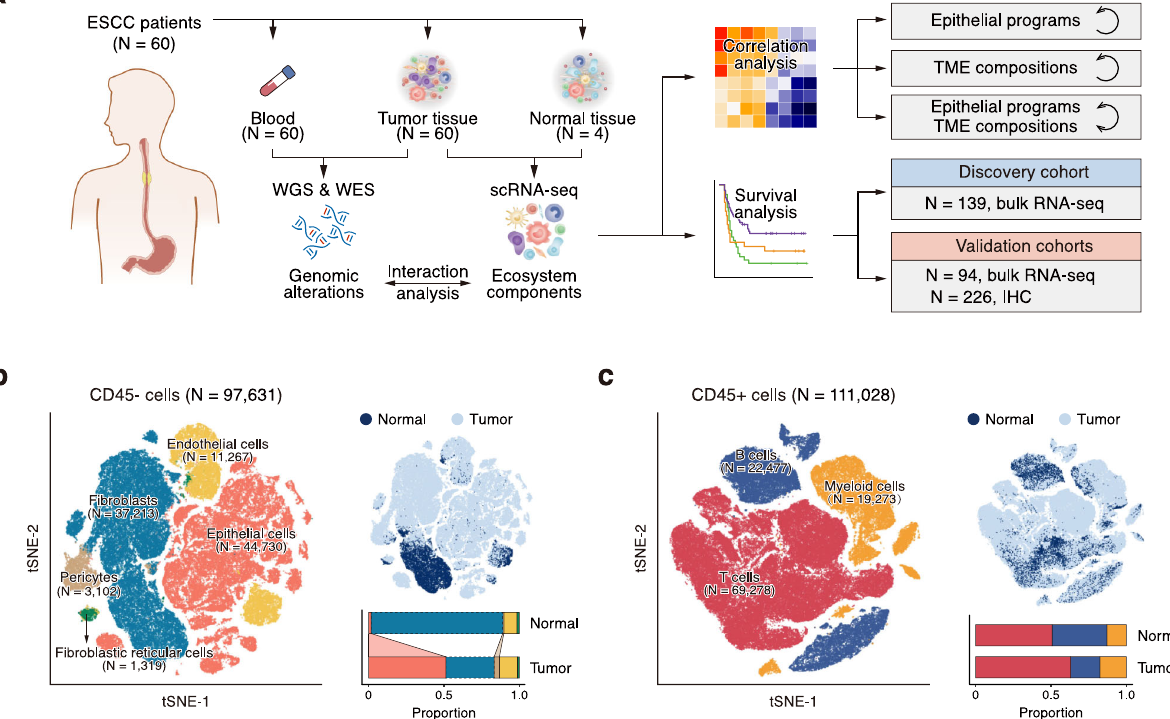
Fig. 1 Overview of ESCC ecosystem characterized by scRNA-seq. a Scheme of the overall study design. b , c tSNE plots of 97,631 CD45- cells ( b ) and 111,028 CD45 + cells ( c ), colored by cell type ( left ) and tissue type ( top right ). The proportions of cell types in normal and tumor tissues are shown on the bottom right (colors as in the left panel). Cell types that signi fi cantly increase (solid line fi lled with color) or decrease (dashed line) in tumor tissue (two- sided Wilcoxon test, P < 0.05) are indicated by links between normal and tumor bars. P values: 0.001 (epithelial cell), 0.001 ( fi broblast), 0.010